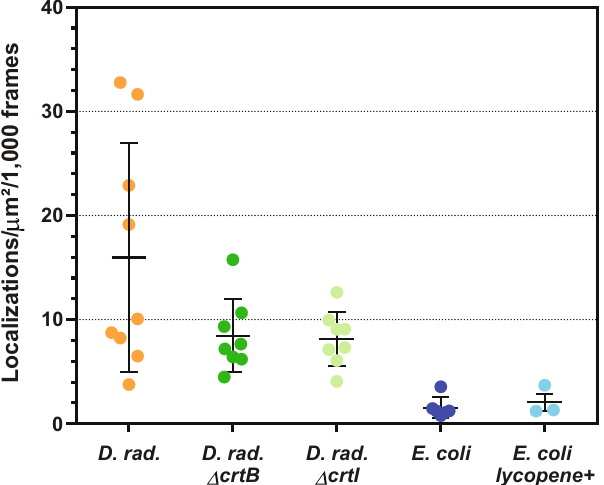
Figure 3. Autoblinking levels (localizations/ μ m 2 /1000 frames) in wild-type and carotenoid biosynthesis mutants ( Δ crtB and Δ crtI ) of D. radiodurans , and in wild-type and lycopene producing E. coli strains. Images were acquired with a 50 ms frametime under continuous 0.8 kW/cm 2 561 nm laser. Individual data points correspond to the autoblinking levels derived from a given stack of images. Means and standard deviations are plotted in the